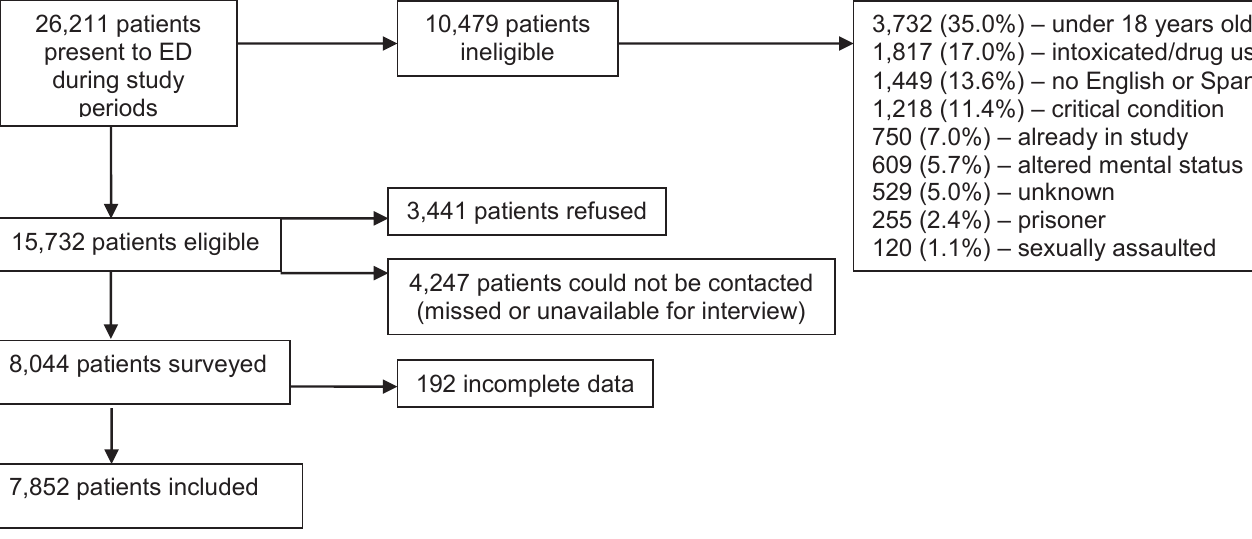
Figure. Emergency department patient